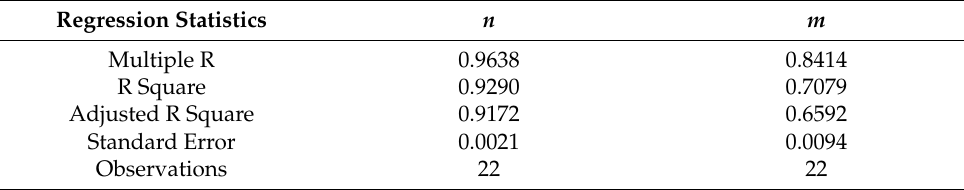
Table 2. Regression statistics for n and m parameters of Equation (6).